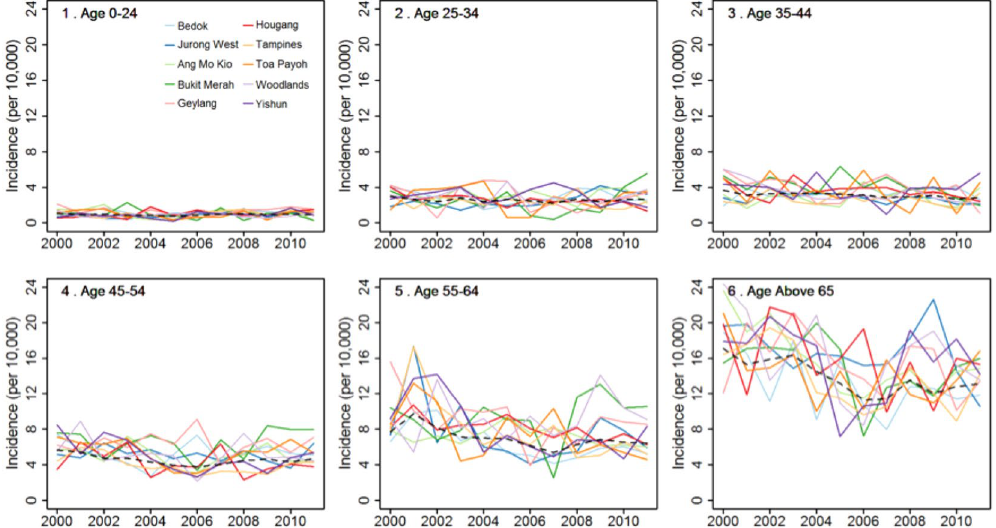
Figure 7. Resident annual time series incidence for ten leading planning areas of Singapore across six different age groups from 2000 to 2010. The incidence is adjusted for underlying susceptible